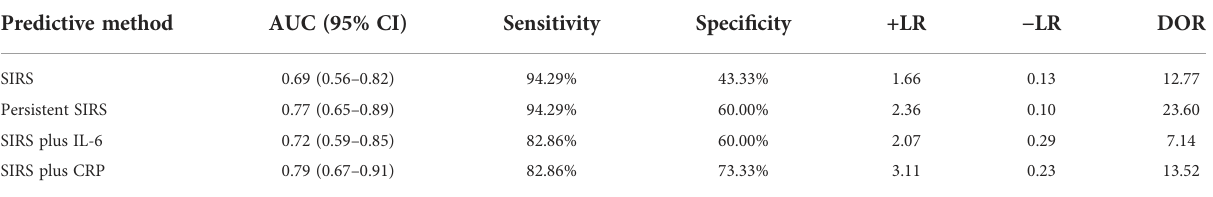
TABLE 5 Comparison of SIRS, persistent SIRS, SIRS plus IL-6, and SIRS plus CRP for the prediction of SAP. Predictive